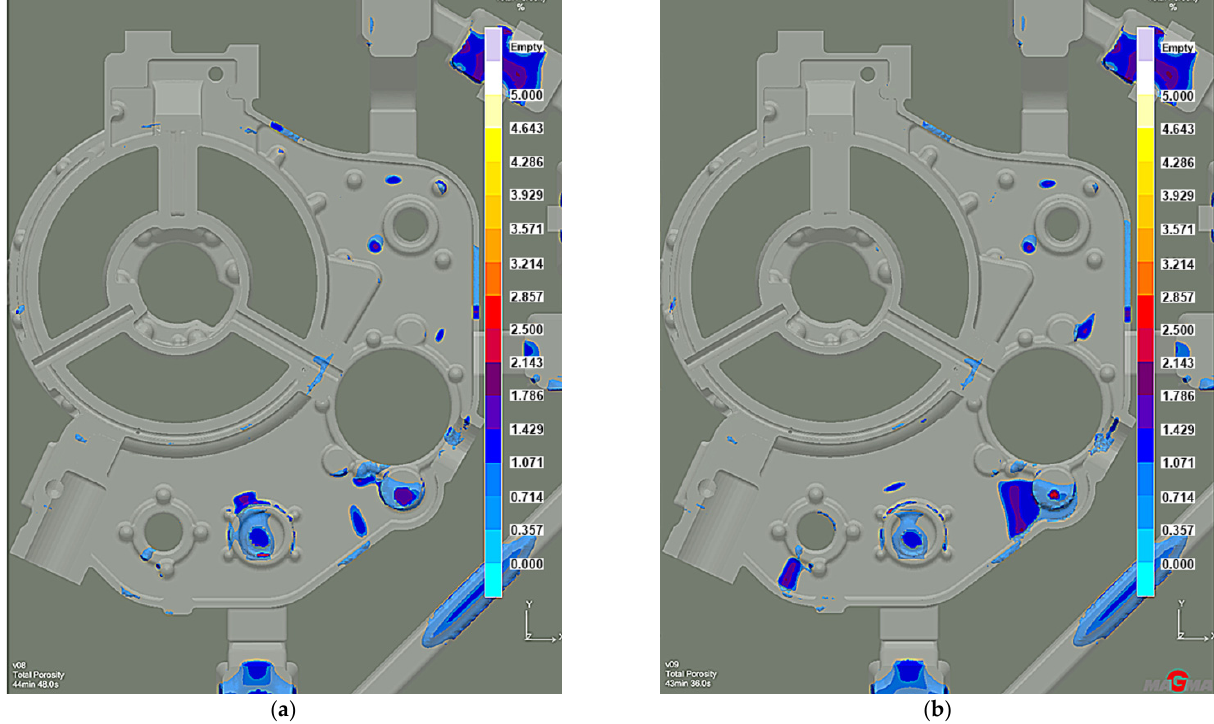
Figure 19. Stage 5 Total Porosity criterion: ( a ) 10 mm chiller thickness; ( b ) 15 mm chiller thickness.